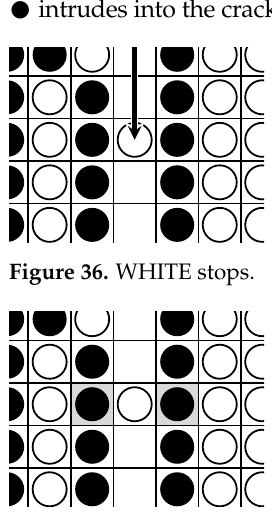
Figure 37. WHITE captures.